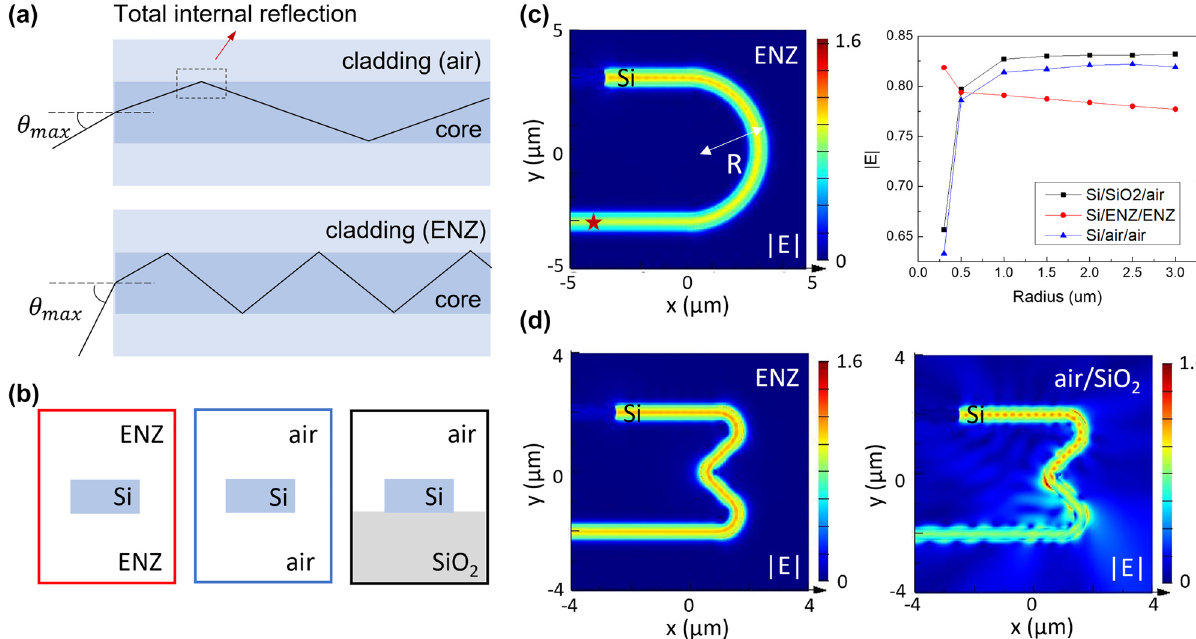
Figure 2: Geometry-invariant waveguides based on ENZ materials robust to waveguide bends. (a) Increased numerical aperture for can be close to 90 ◦ . (b) Cross sectional schematic of the Si waveguide waveguides with ENZ materials as the cladding layer, where 𝜃 max within an ENZ dielectric environment, air, and on top of a glass substrate, respectively. (c) Comparison of optical transmission efficiency for Si waveguides bent to different curvatures under TE polarization. The Si waveguide within the ENZ index environment shows a higher transmission efficiency especially at small radii ( R < 0.5 μ m). A field monitor was placed in the output port (the star position). environment. Waveguide cross-section is (d) Comparison of optical transmission for a bent Si waveguide in ENZ versus in air/SiO 2 0.4 × 0.2 μ m 2 , and the plotting wavelength is 𝜆 = 1.3 μ